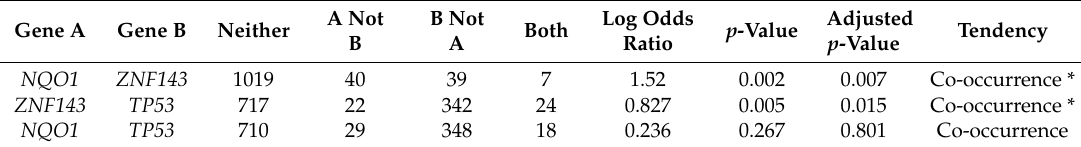
Figure 6. ZNF143 expression is related to disease-free survival of breast cancer patients according to TCGA. ( A ) Higher levels of ZNF143 mRNA expression and copy number alterations were associated with increased disease-free survival in the TCGA cohort. The log-rank value was 0.038. Patients with higher levels of ZNF143 gene expression are shown in red and patients without higher levels of ZNF143 gene expression are shown in blue. ( B ) Lower levels of ZNF143 mRNA expression were associated with decreased disease-free survival in the TCGA cohort. The log-rank value was 0.030. Patients with lower levels of ZNF143 gene expression are shown in red and patients without lower levels of ZNF143 gene expression are shown in blue. In all analyses, patients not applicable for any of the selected attribute(s) were excluded. Table 1. Gene Co-occurrent Alteration .